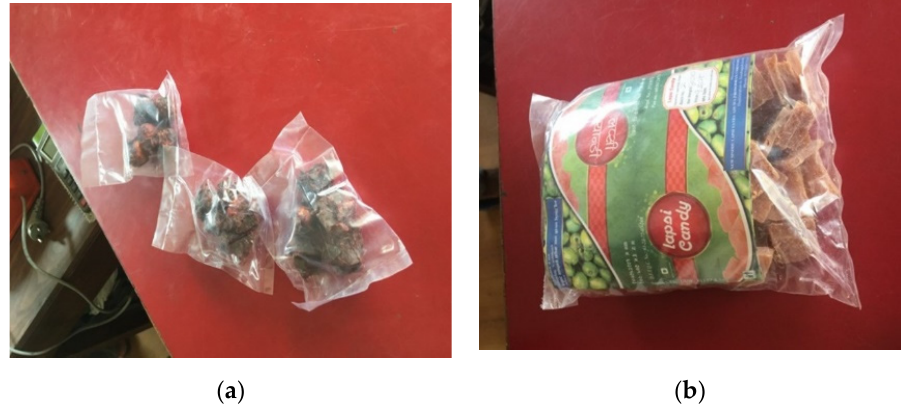
Figure 4. The figure ( a , b ) shows the NTFPs from small cottage industry in the Shreechap